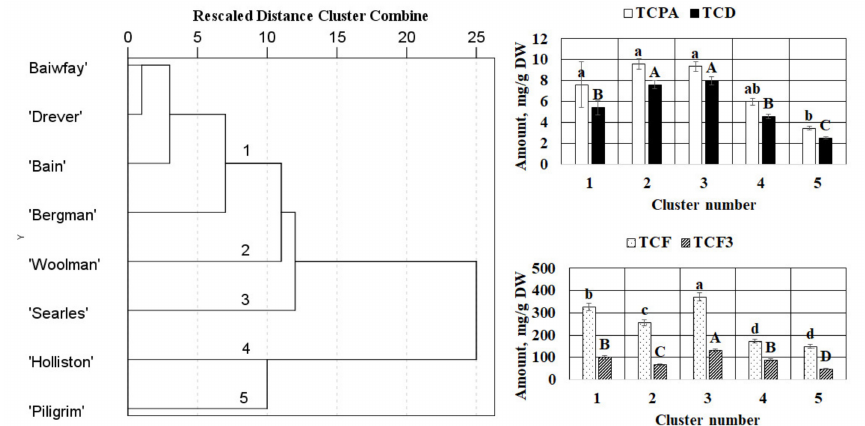
Figure 4. The dendrogram of hierarchical cluster analysis (HCA) of cranberry fruit based on the phytochemical composition and mean values of total contents of the identified compounds (mg / g DW) of clusters extracted using HCA. TCD—total content of dihydrochalcones; TCPA—total content of